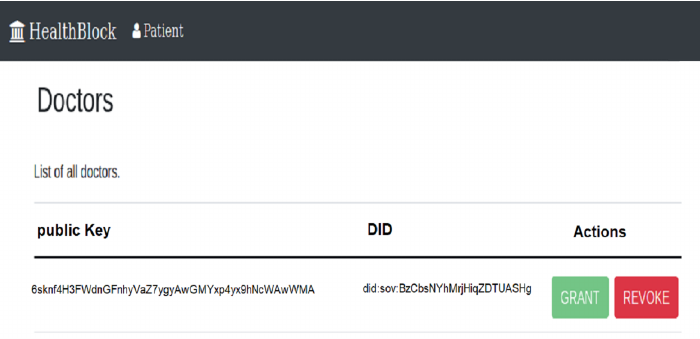
Figure 10. Bob delegates access related to his